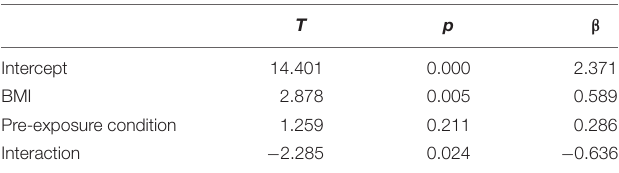
TABLE 3 | Multilevel analysis